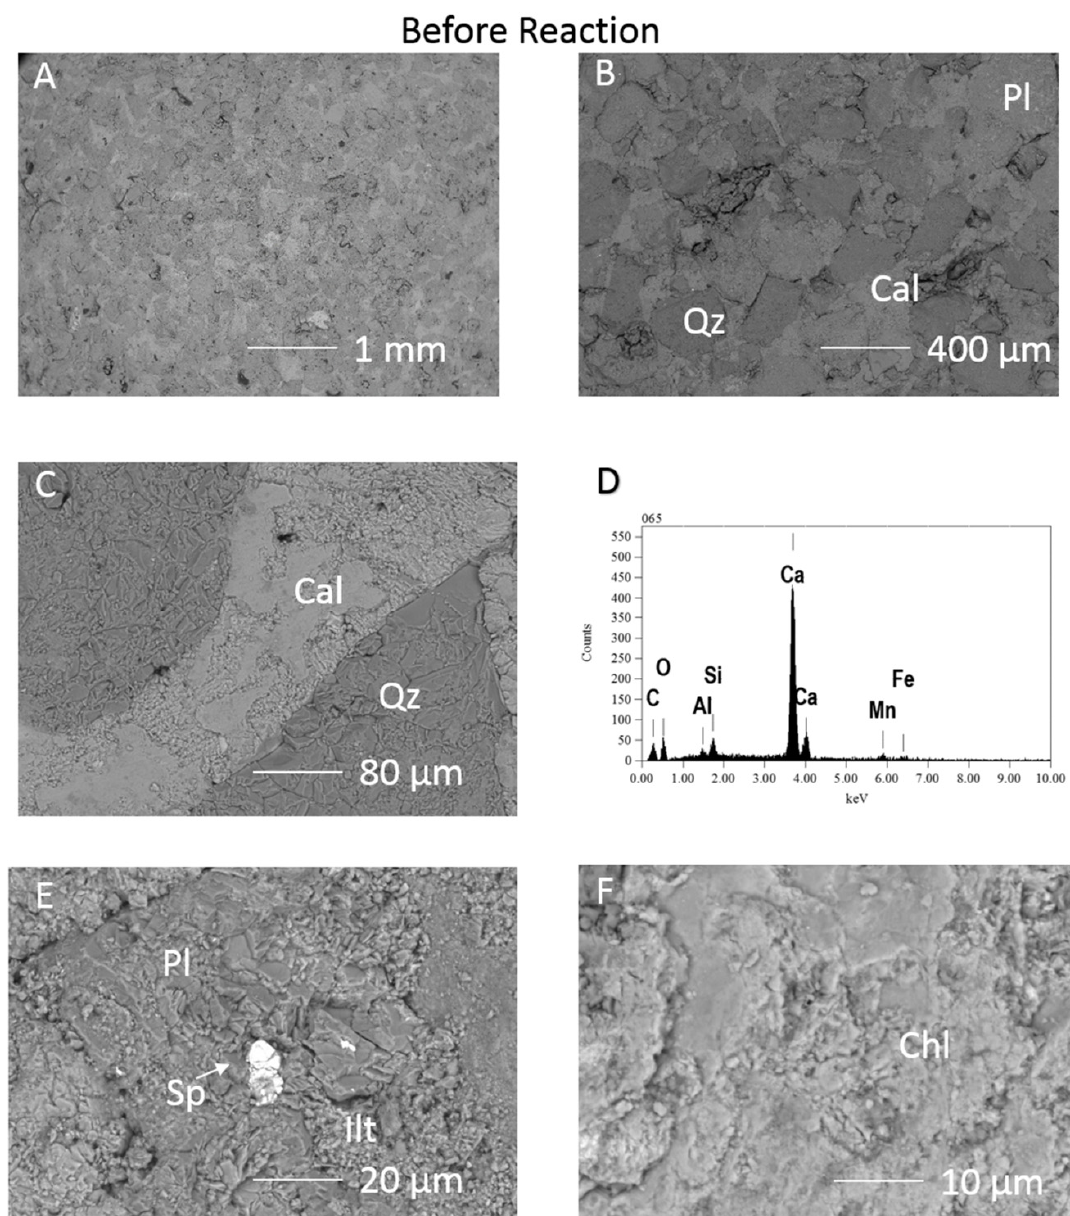
Figure 2. SEM images of the 1053m Calcite cemented cap ‐ rock before reaction ( A ) surface view of the framework grains with calcite cement; ( B ) and ( C ) quartz and plagioclase framework grains cemented by calcite; ( D ) EDS spectrum of the calcite cement containing Mn and possibly Fe; ( E ); Plagioclase with areas of illitisation, and FeZn sulphide ( F ) Chlorite surface. Qz = quartz, Cal = calcite, Chl = chlorite, Pl = plagioclase, Sp = sphalerite or FeZn sulphide, Ilt = illite.